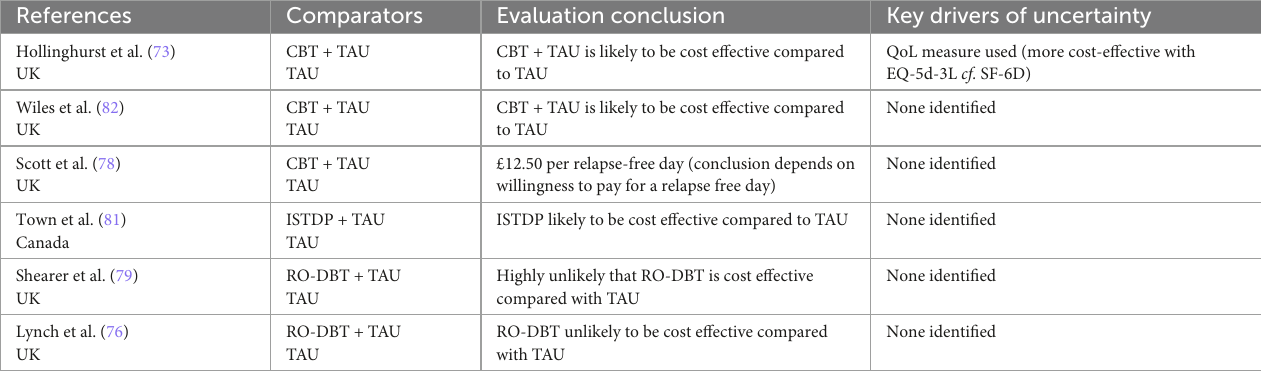
TABLE 4C Summary of authors’ conclusions, and key drivers of uncertainty for economic evaluations of psychological interventions.